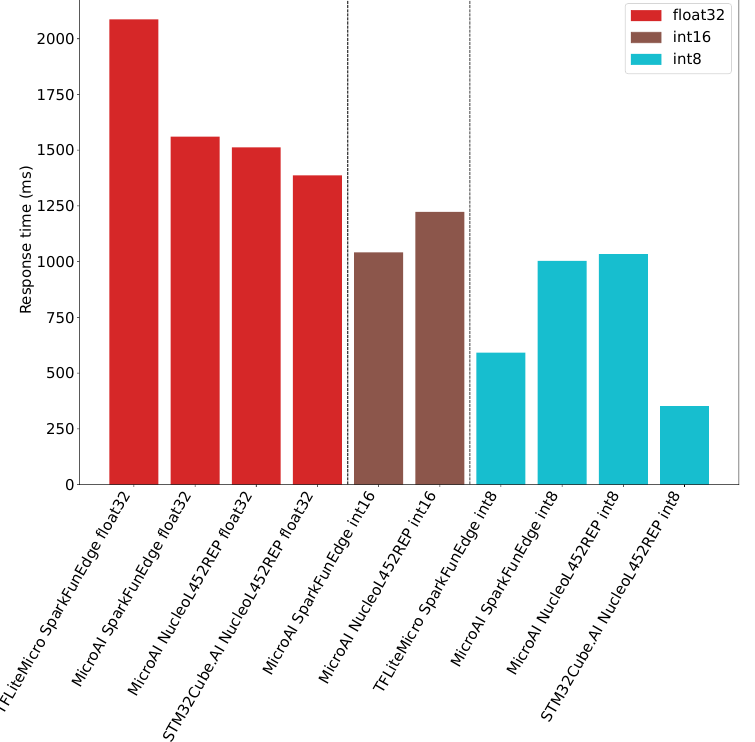
Figure 12. Inference time for 1 input for TFLite Micro, STM32Cube.AI and MicroAI with 80 filters per